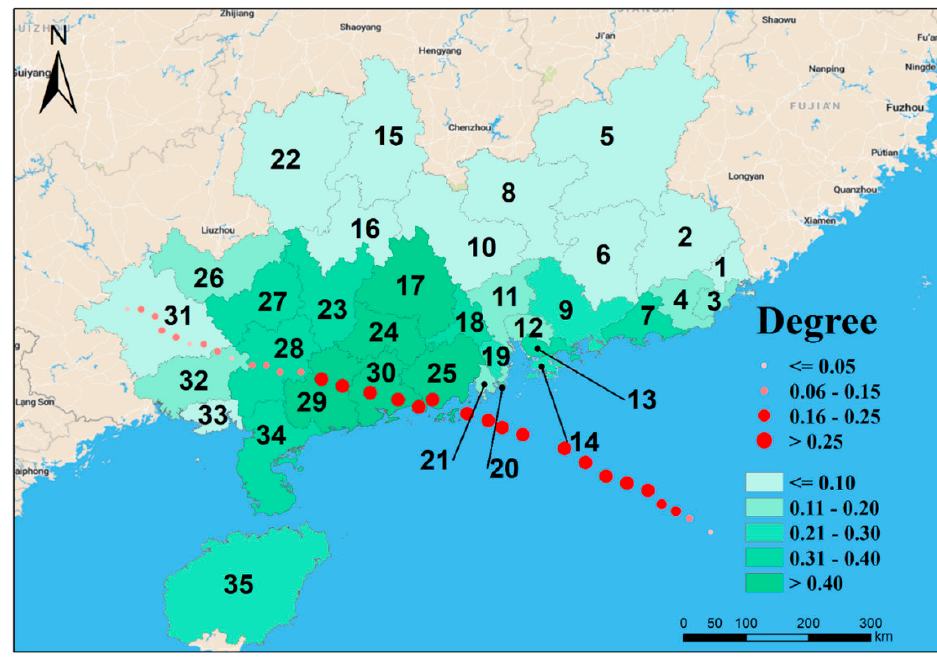
Figure 7. Normalized centrality degree of disaster network in different cities and different times.